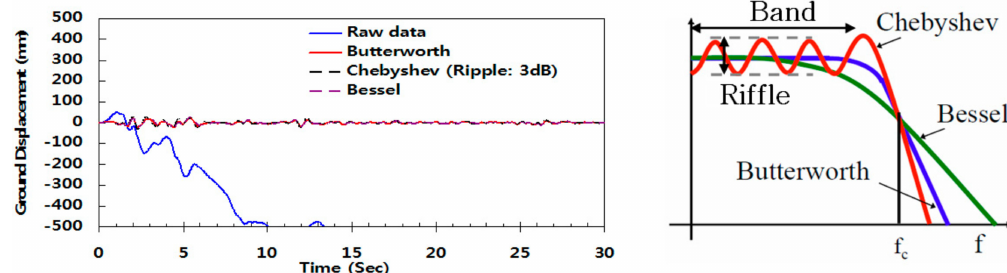
Figure 3. Displacement response histories with / without filters and comparison of noise